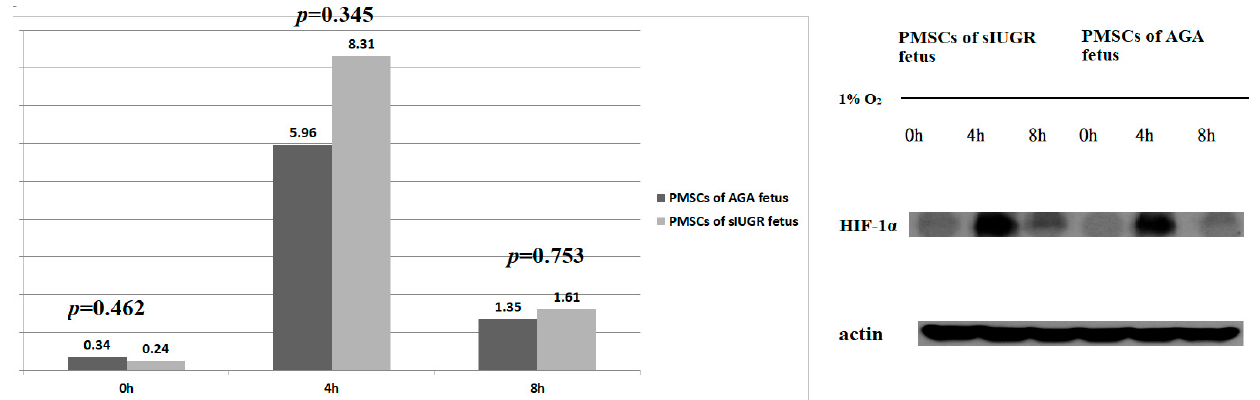
Figure 1. HIF-1 α protein expression in placental mesenchymal stem cells (PMSCs) cultured under normoxic conditions and fold changes (FCs) after 4 and 8 h under hypoxic conditions; PMSCs from monochorionic twin fetuses with appropriate-for-gestational-age (AGA) growth and selective intrauterine growth restriction (sIUGR). HIF-1 α protein-0: HIF-1 α protein expression under normoxic conditions. HIF-1 α protein-FC4: HIF-1 α protein expression FCs after culturing for 4 h under hypoxic conditions. HIF-1 α protein-FC8: HIF-1 α protein expression FCs after culturing for 8 h under hypoxic conditions. HIF-1 α protein expression under normoxic conditions is expressed as a fraction of actin expression (HIF-1 α /actin). HIF-1 α protein-FC4 and HIF-1 α protein-FC8 are expressed as (protein expression after 4 [8] h of hypoxia) ÷ (protein expression under normoxic conditions). Data are expressed as the median. P values were generated using the Wilcoxon signed-rank test.